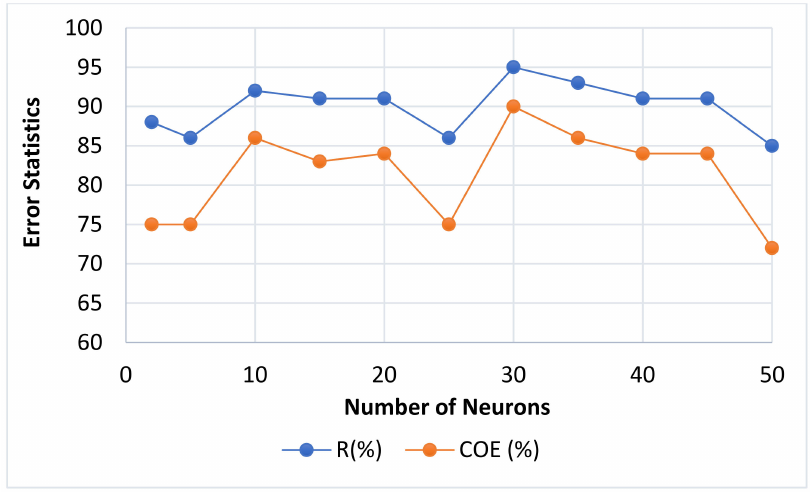
Figure 6. Overall Performance Error Statistics with R (%) and COE